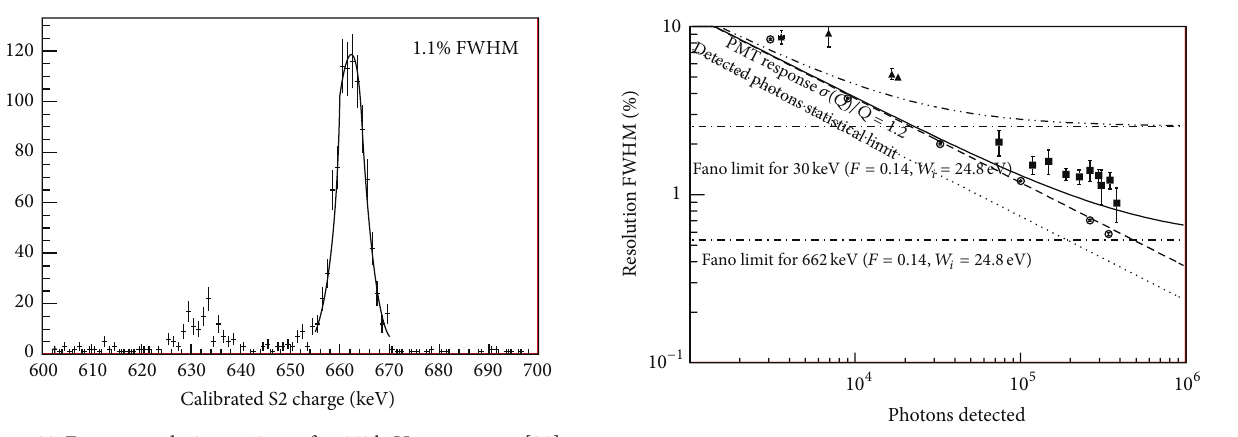
Figure 32: Energy resolution at 10atm for 662 keV gamma rays [38].